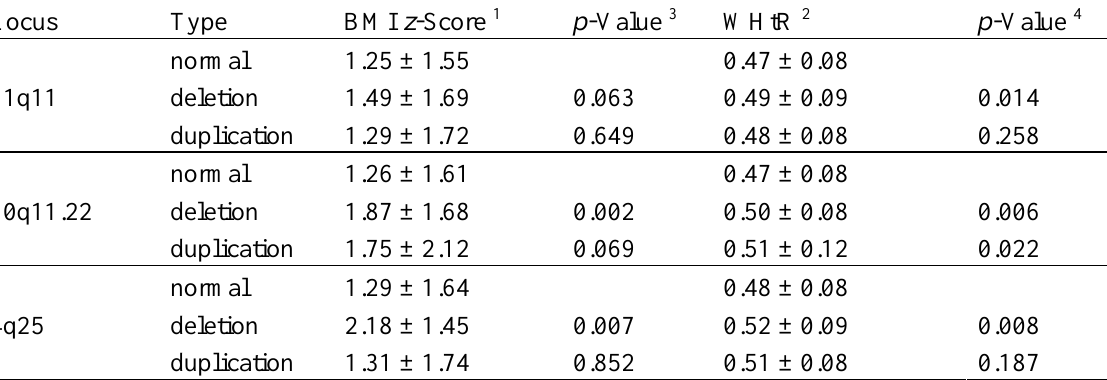
Table 4. Associations between the three positive CNV loci and BMI z -score, WHtR.